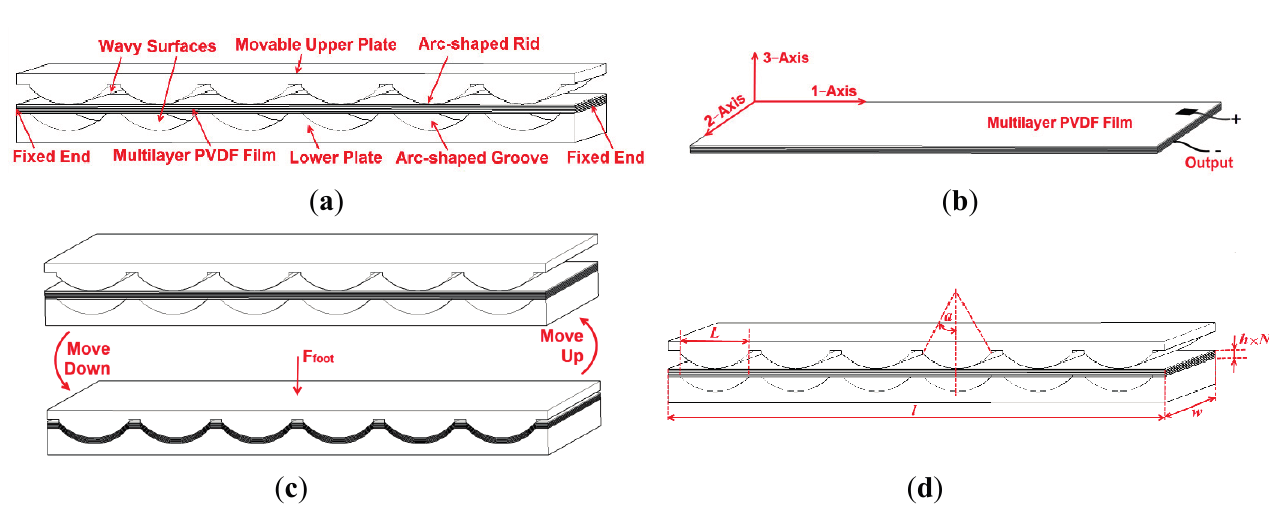
Figure 1. ( a ) The sandwich structure of the harvester; ( b ) The multilayer PVDF film; ( c ) The force applied by foot drive the upper plate to move up and down circularly; ( d ) The design